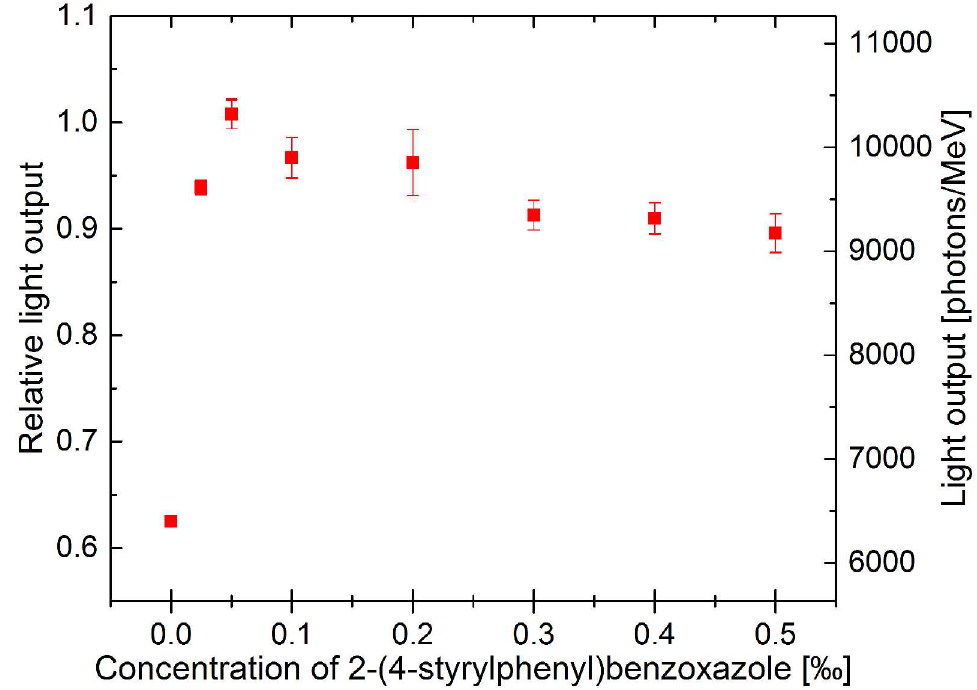
Fig 8. Relative and absolute light output of the J-PET plastic